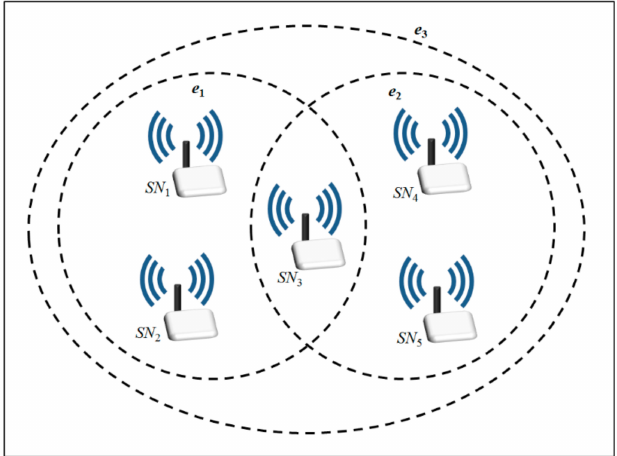
Figure 1. In a key hypergraph, one sensor node is allowed to belong to multiple independent